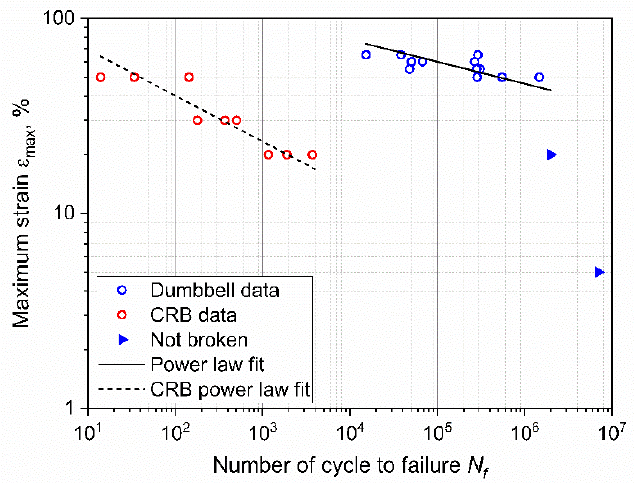
Figure 12. Wöhler curve obtained from axisymmetric dumbbell specimens (blue) and CRB (red) of CB filled NBR at a frequency of 4 Hz and a load ratio R ε of 0.5. The fitting power laws of the axisymmetric dumbbell specimen (continuous line) and of CRB (dashed line) were obtained using ASTM E739–10.